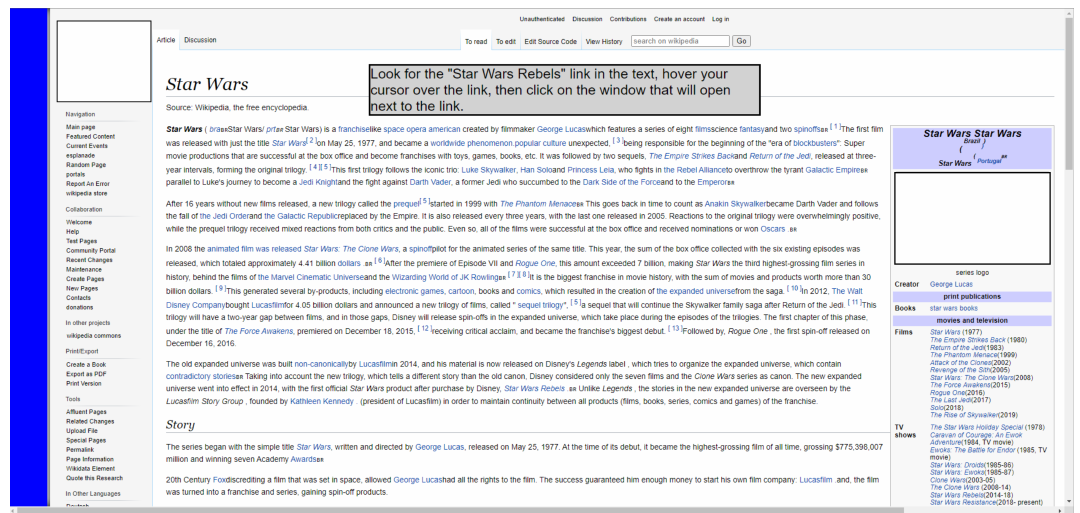
Figure 11. Simulated scenario 3 based on a generic wiki platform in the web service with PB.